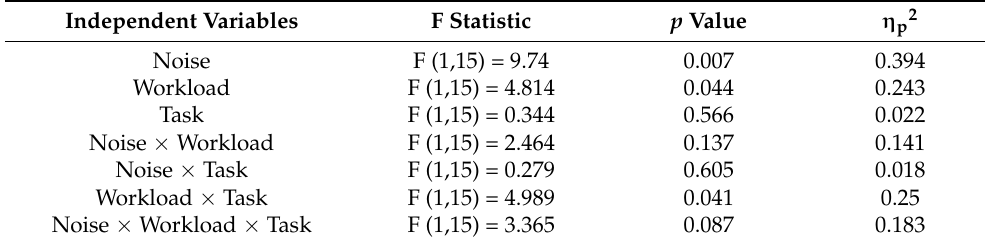
Figure 4. Response times (ms) during a simple response time (SRT) task, without (No Noise) and with noise (Noise), before (PRE) and after (POST) the workload. * represents significant difference at p < 0.05, and bars represent standard errors.